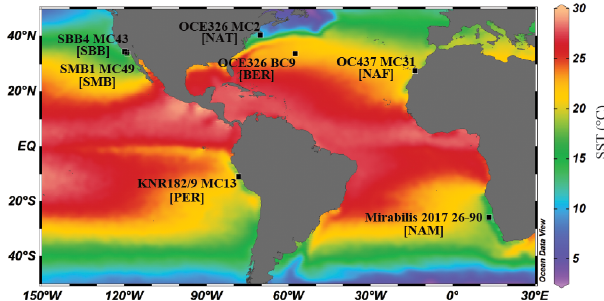
Figure 1. Sample location and annual mean SST from the WOA18 product (Locarnini et al., 2019) plotted with the Ocean Data View (ODV) software (Schlitzer, 2021). Abbreviations for each site used in the main text are given within